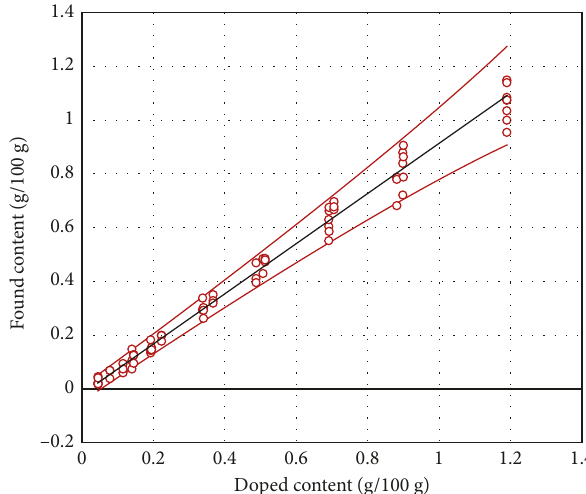
Figure 7: Linear weighted regressions for the matrices lip gloss, lip balm, and lipstick. Plot: detected content of MOAH in g/100g as a functionofspikedcontent ofMOAHing/100g,0.95predictionbands.